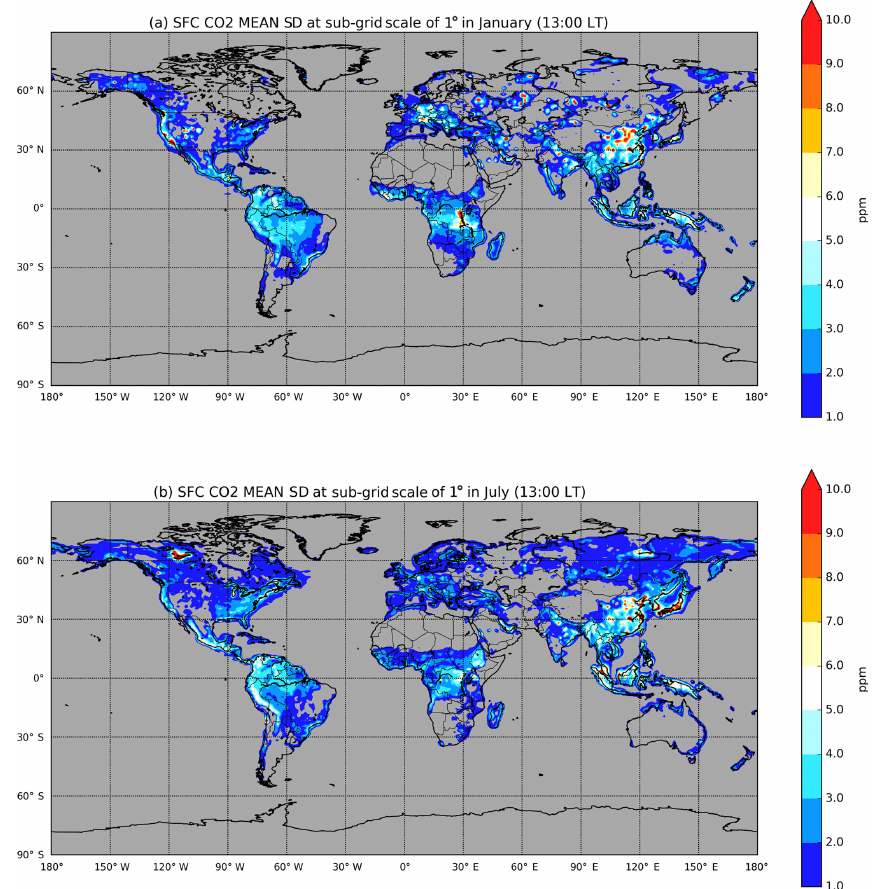
Figure 11. Monthly mean surface CO 2 small-scale variability ( σ ) within 1 ◦ × 1 ◦ grid boxes (ppm) at 13:00 local time in (a) January and (b) July. Grey shading denotes σ < 1 .